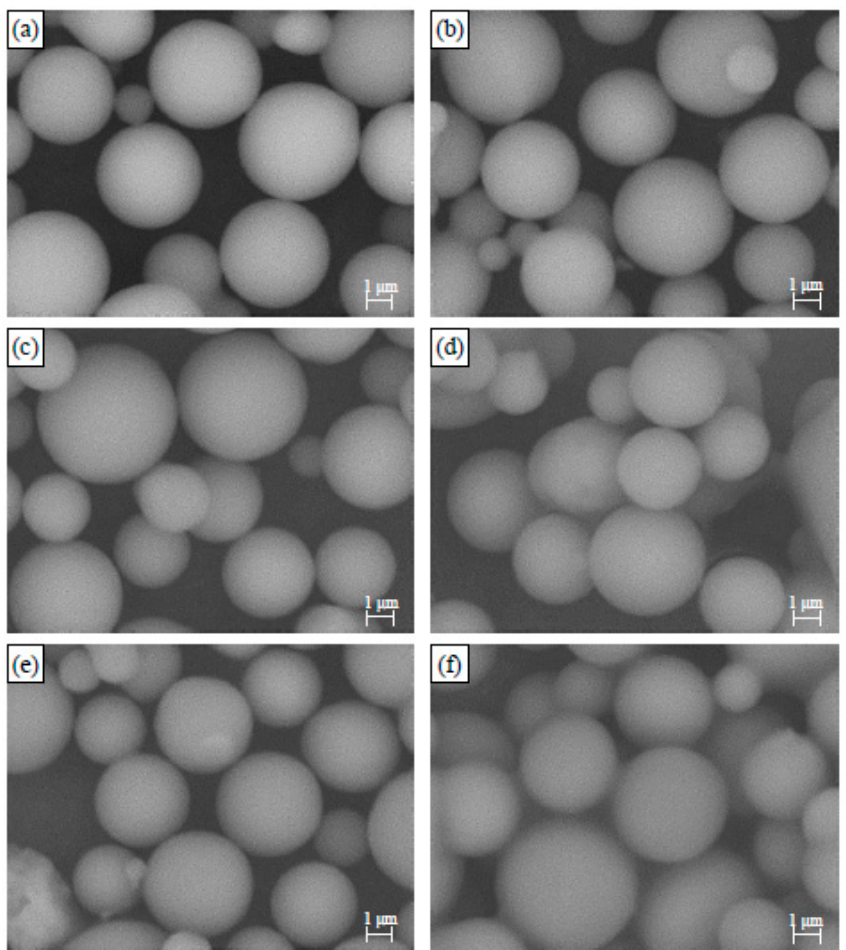
Figure 1. SEM images at 10,000× magnification of ( a ) unfunctionalized MSU-2, and MSU-2 function- alized with TEPA loadings of ( b ) 20 wt%, ( c ) 30 wt%, ( d ) 40 wt%, ( e ) 50 wt%, and ( f ) 60 wt%.